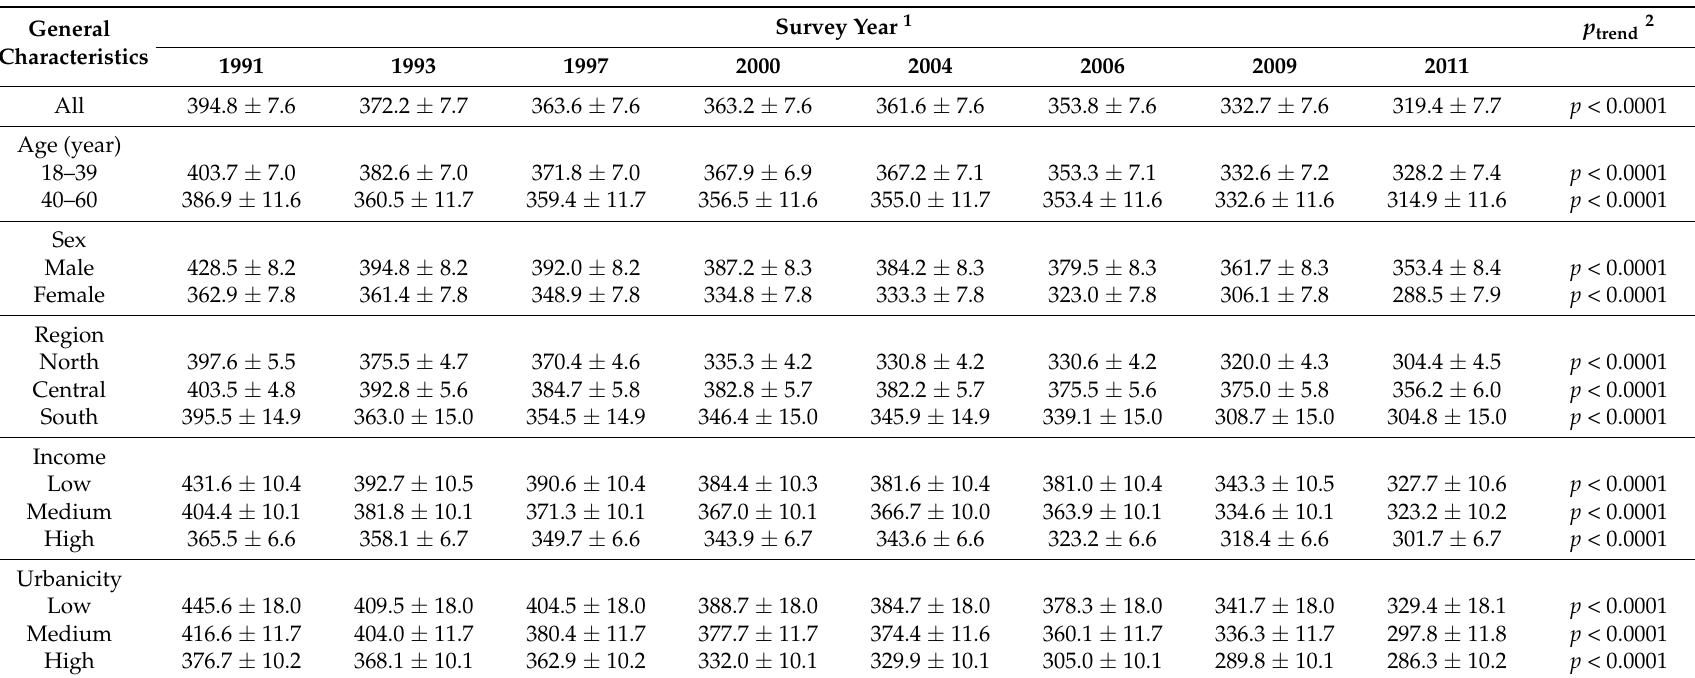
Table 3. Daily carbohydrate intake (g), by age, sex, geographical region, income, and urbanicity, in Chinese rural adults from 1991 to